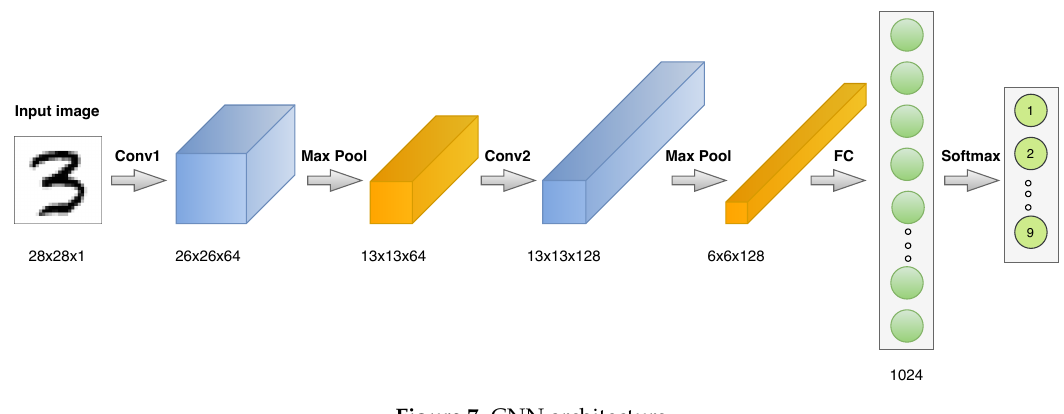
Figure 7. CNN architecture.